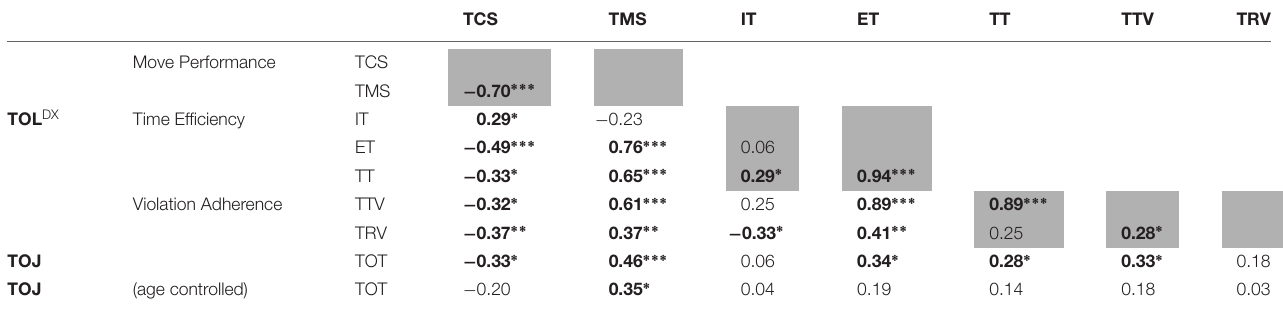
TABLE 4 | Spearman’s rho correlations coefficient values (and significance levels) between TOJ and particular outcome measures of TOL DX . TCS TMS IT